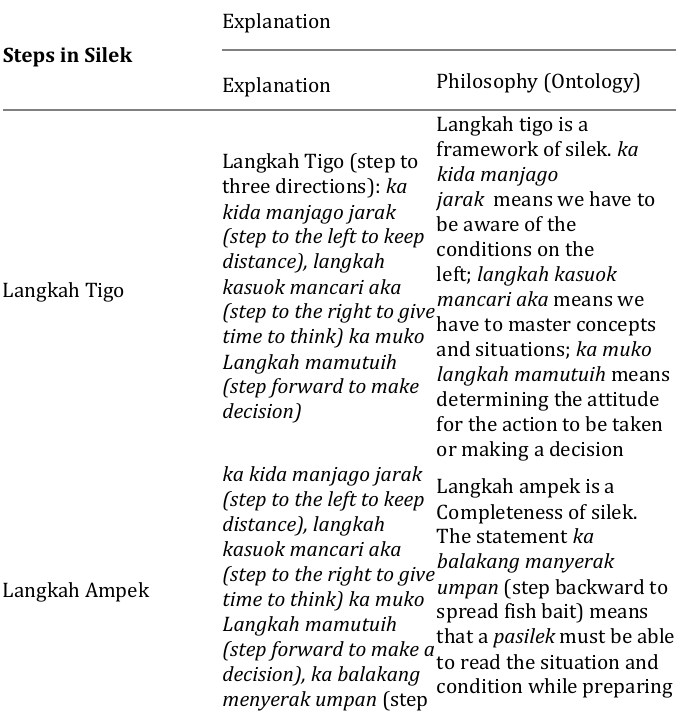
Table 1 Construction of Science in